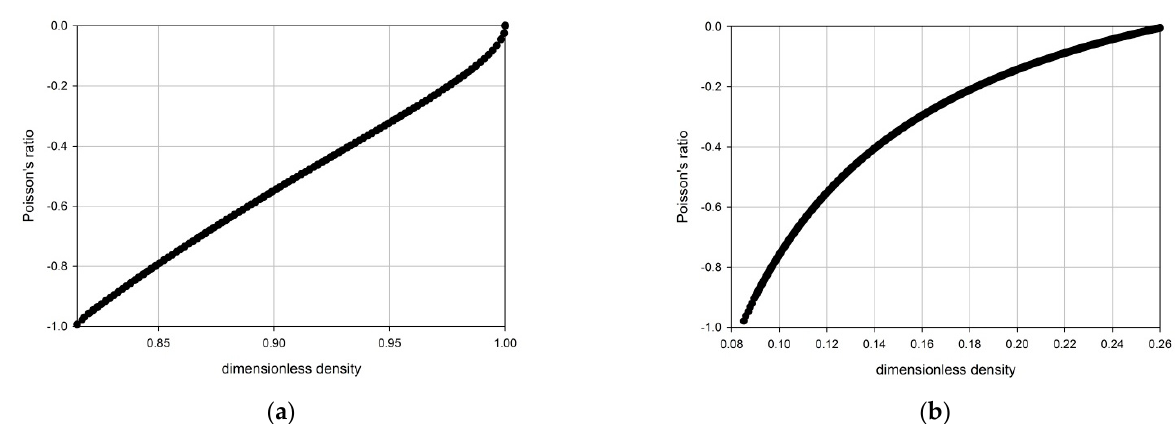
Figure 2. Variation of Poisson’s ratio vs dimensionless density in auxetic media: ( a ) Equation (28a); ( b ) Equation (28b).